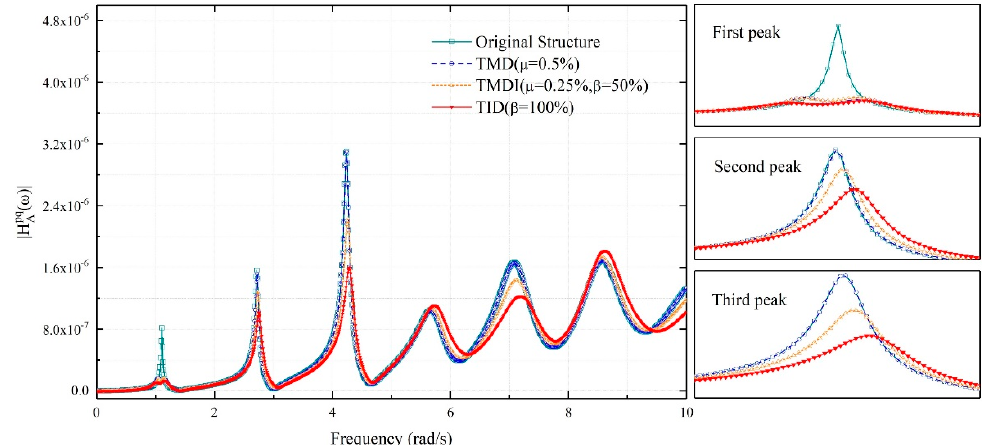
Figure 12. Acceleration transfer function at the top floor for different structural control schemes.